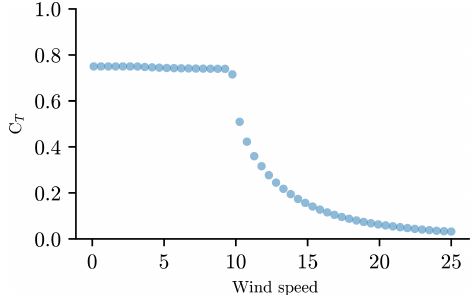
Figure 4. The thrust coefficient curve for the 3.35MW turbine used in this